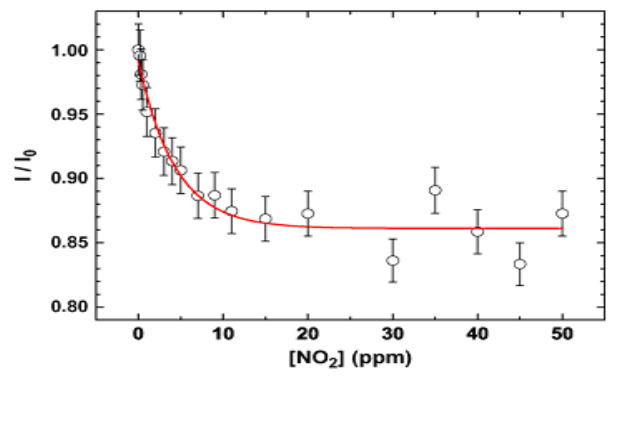
Figure 12. Quenching ratio at room temperature as a function of the NO solid curve is a best fit to data obtained by using the